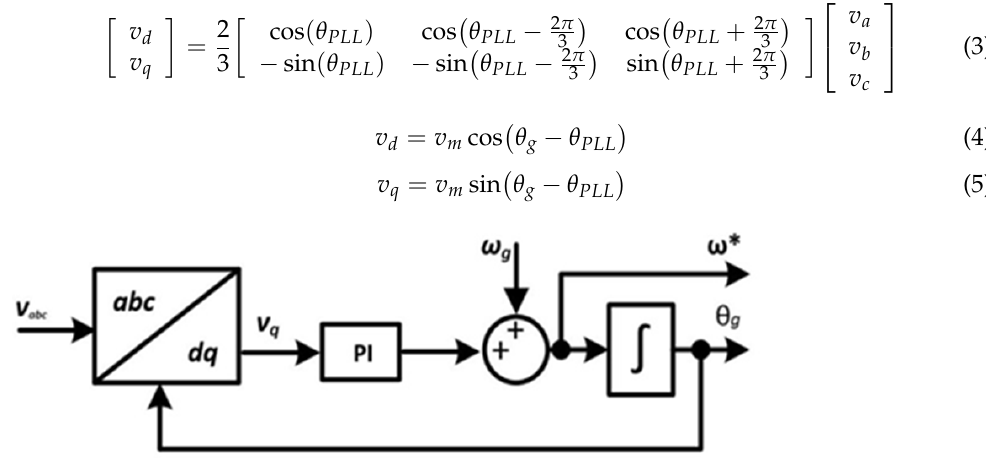
Figure 3. SRF-PLL algorithm.